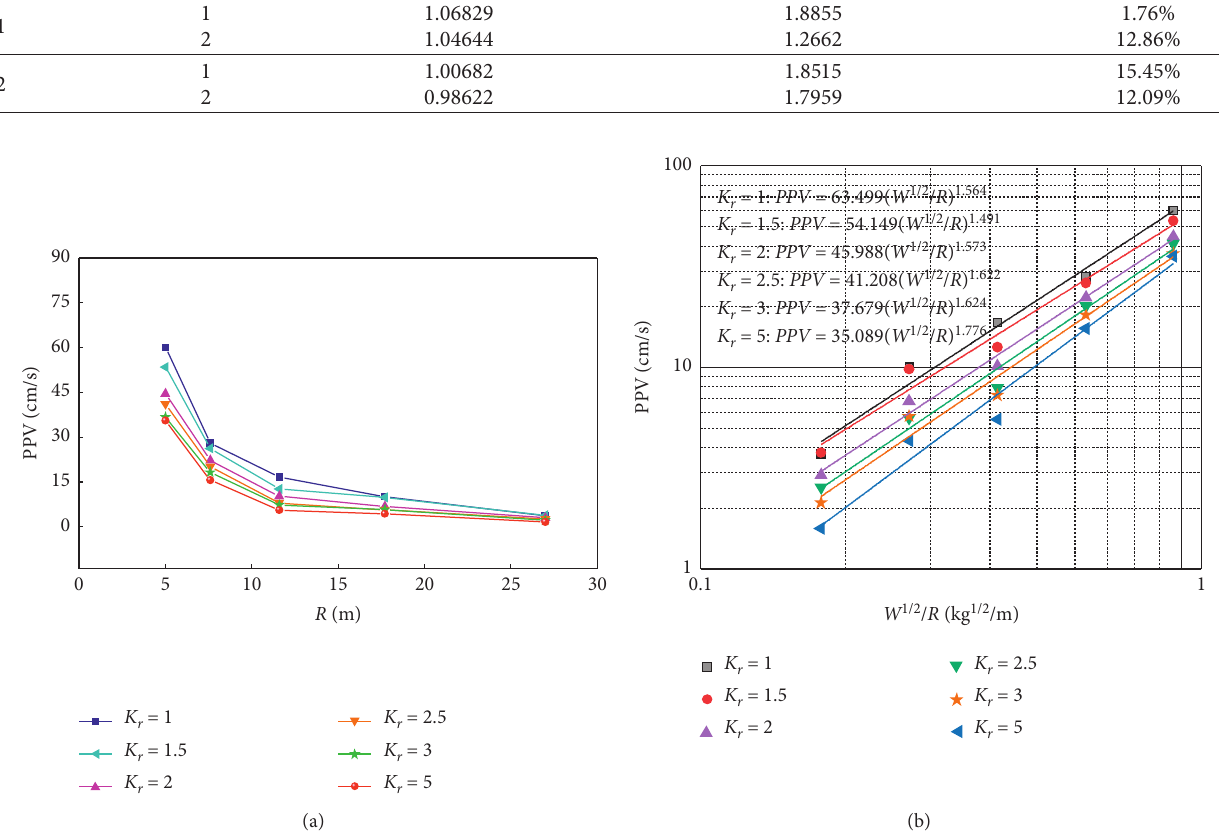
r . (a) PPVs. (b) Vibration attenuation